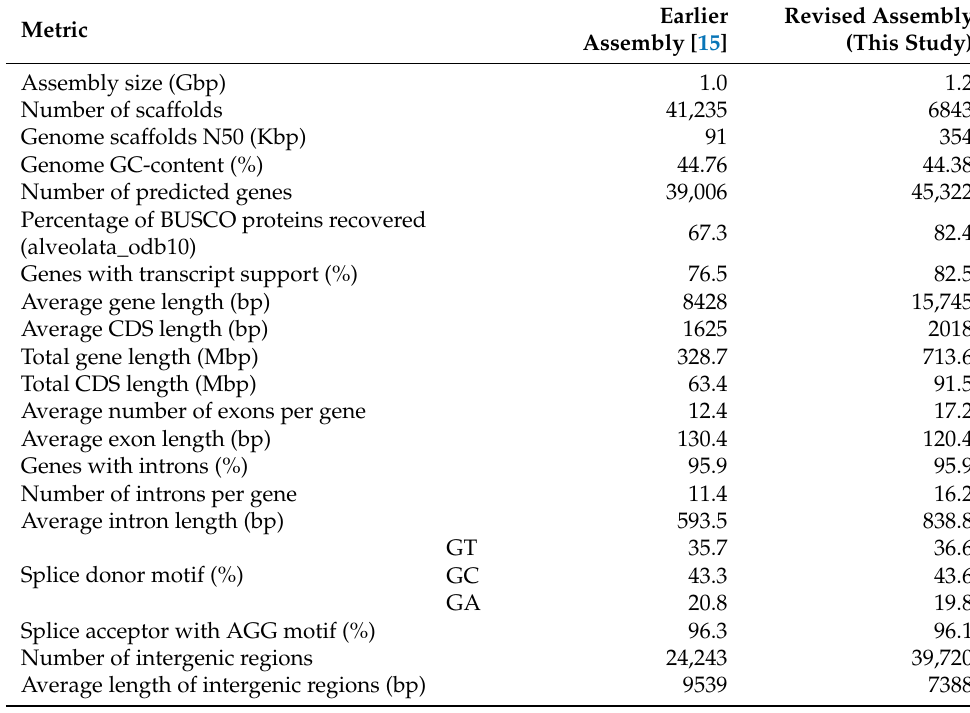
Table 1. Metrics of the revised genome assembly and predicted genes of C. goreaui , compared to the earlier assembled